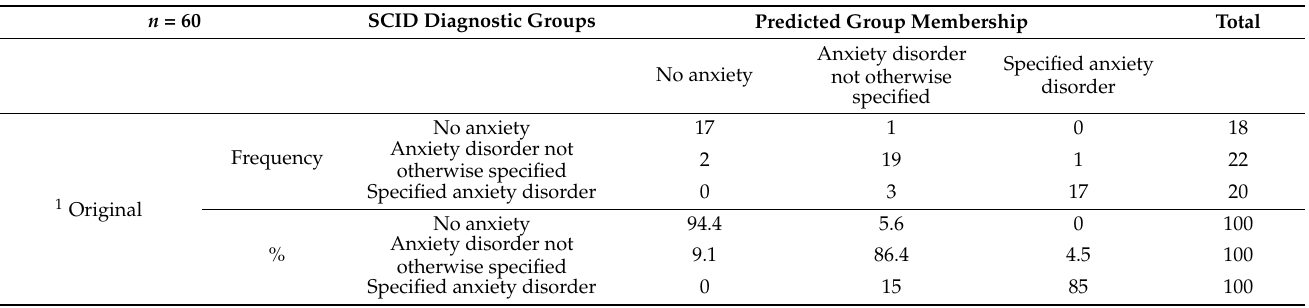
Table 6. Diagnostic classification of the cases by the S-SARS discrimination